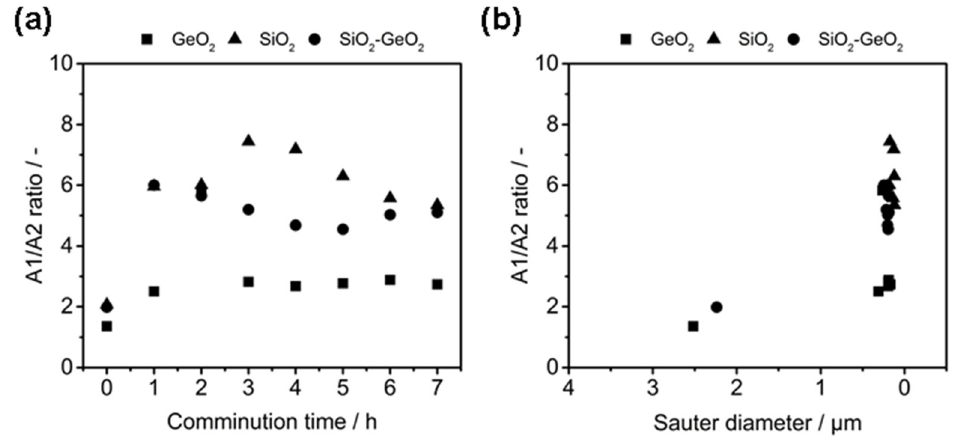
Figure 6. A1/A2 ratio as a function of comminution time ( a ) and Sauter diameter ( b ).